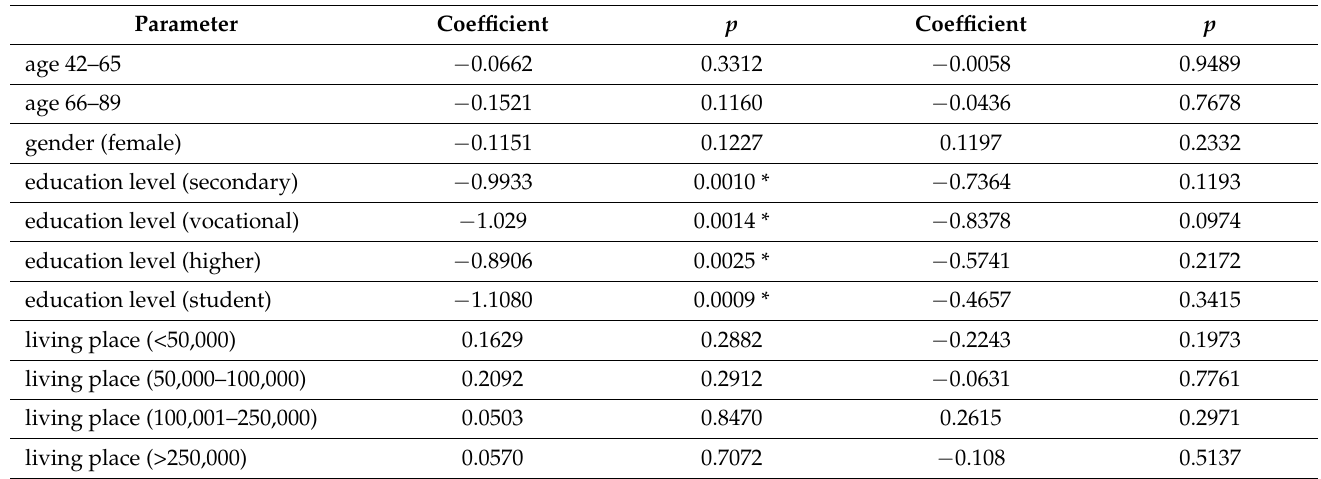
Table 2. Multivariate linear regression analysis of the association between age, gender, education level, living place and the effect of lifestyle on the number of meals consumed daily during the COVID-19